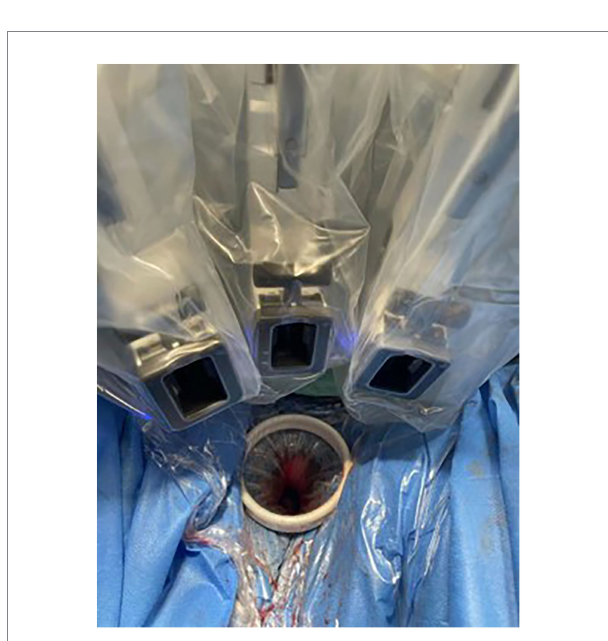
FIGURE 2 Presented the staggered triangular constructed by the endoscope and two robotic